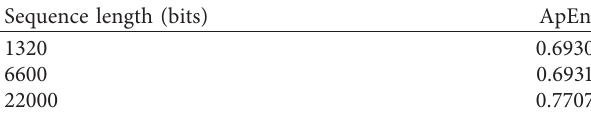
Table 4: ApEn values corresponding to different sequence